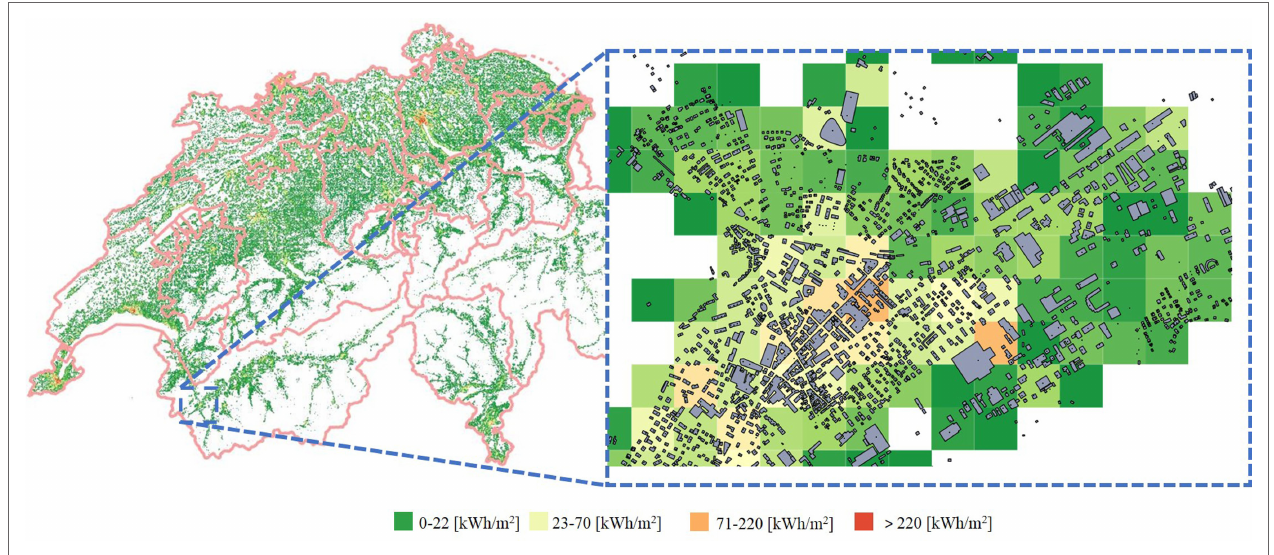
FIGURE 6 | Swiss geographical information system map for heat demand and zoom on the town of